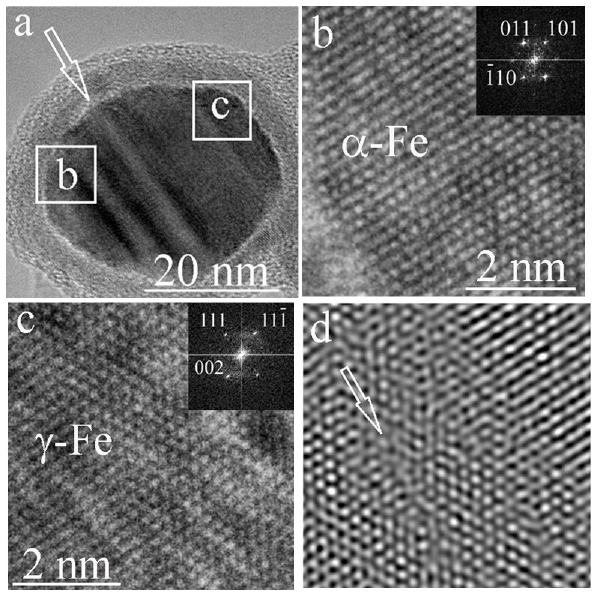
Figure 8. The particle through which the deformation bands pass ( a ). One of the bands is indicated by a white arrow; in the left part is the α– Fe ( b ), in the right part of the particle is the γ – Fe phase ( c ); ( d ) is the inverse FFT image of the deformation band (indicated by an arrow) with a structure close to amorphous. The uppermost layer of the particle is curved graphite layers. Particles of similar nature were obtained under different conditions. For example, under high pressure conditions, carbon ‐ encapsulated iron carbide nanoparticles were synthesized in [17]. The material consists of the round carbide particles (5–40 nm) covered with onion ‐ like carbon shells that are embedded into the carbon matrix. In another work, single ‐ domain LaC 2 microcrystals encapsulated within nanoscale polyhedral carbon particles have been synthesized in a carbon arc [18]. Typical particle sizes are on the order of 20 to 40 nm. Observation of the crystals indicates that LaC 2 is protected from degradation by the carbon polyhedral shells of the nanoparticles. The encapsulation of many materials within a hollow graphitic cage was carried out using an electric arc discharge [19]. Iron particles ( α – Fe, γ – Fe;) and a carbide phase were wrapped in graphitic carbon. The excellent protective nature of the outer graphitic cages against the oxidation of the inner materials was demonstrated. The synthesis method using an arc chamber to encapsulate controlled ‐ size ferromagnetic transition metals, such as Fe, Co, and Ni, inside protective graphite shells was presented in [20]. There are works in which an oxygen ‐ containing layer of iron was found. Iron nanoparticles embedded in an activated carbon matrix were synthesized in [21] by a pyrolysis process. The investigated structure exhibits an onion ‐ like morphology that consists of a γ – Fe core surrounded by a double α– Fe (inner)/ γ – Fe 2 O 3 (outer) shell. Cubic and tetragonal modifications of maghemite were found within CNT, synthesized using the CVD method [22]. The outer shell, made of Fe 2 O 3 , was found on the surface of iron carbide particles in carbon nanofibers obtained by the CVD method in the presence of an Fe catalyst [23]. There are also thin heterogeneous Fe 2 O 3 /Fe 3 C ‐ graphene layers for charge ‐ storage amplification in Li ‐ ion batteries obtained via the CVD method in two steps. The first step was to fabricate the nanoporous C ‐ Fe 2 O 3 layer; then a few graphene layers were grown on Fe 2 O 3 /Fe 3 C [24].